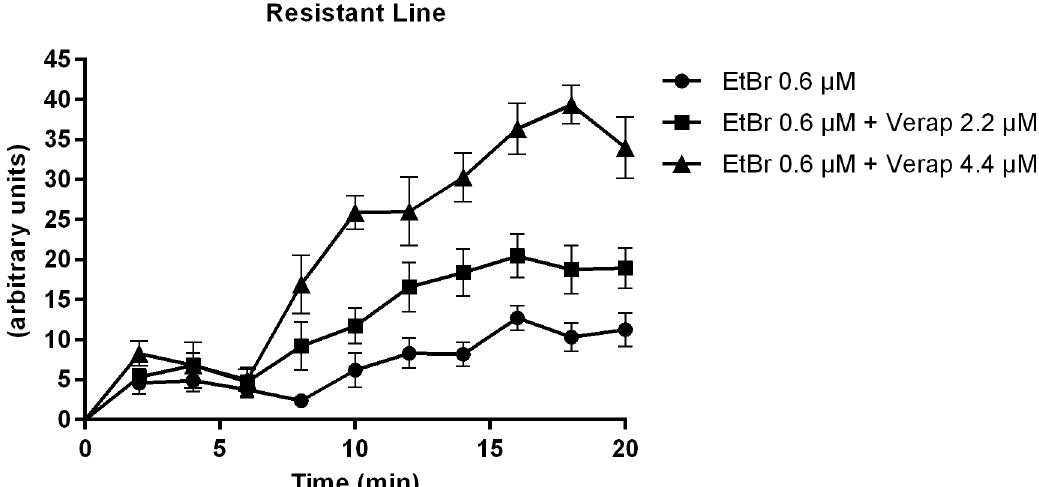
Fig 8. Variation in EtBr accumulation (Mean relative fluorescence). In the absence and presence of 2.2 μ M and 4.4 μ M of Verapamil in S . mansoni PZQ- resistant adult males. Three worms were used for each group and the experiment was performed three times. Quantification measurements were made in three areas of the worm central section (below the cecum ramification) and background fluorescence was subtracted for each parasite at each time-point. The average measurement was calculated for each time-point. Data are expressed as mean fluorescence of EtBr accumulated intracellularly over time.